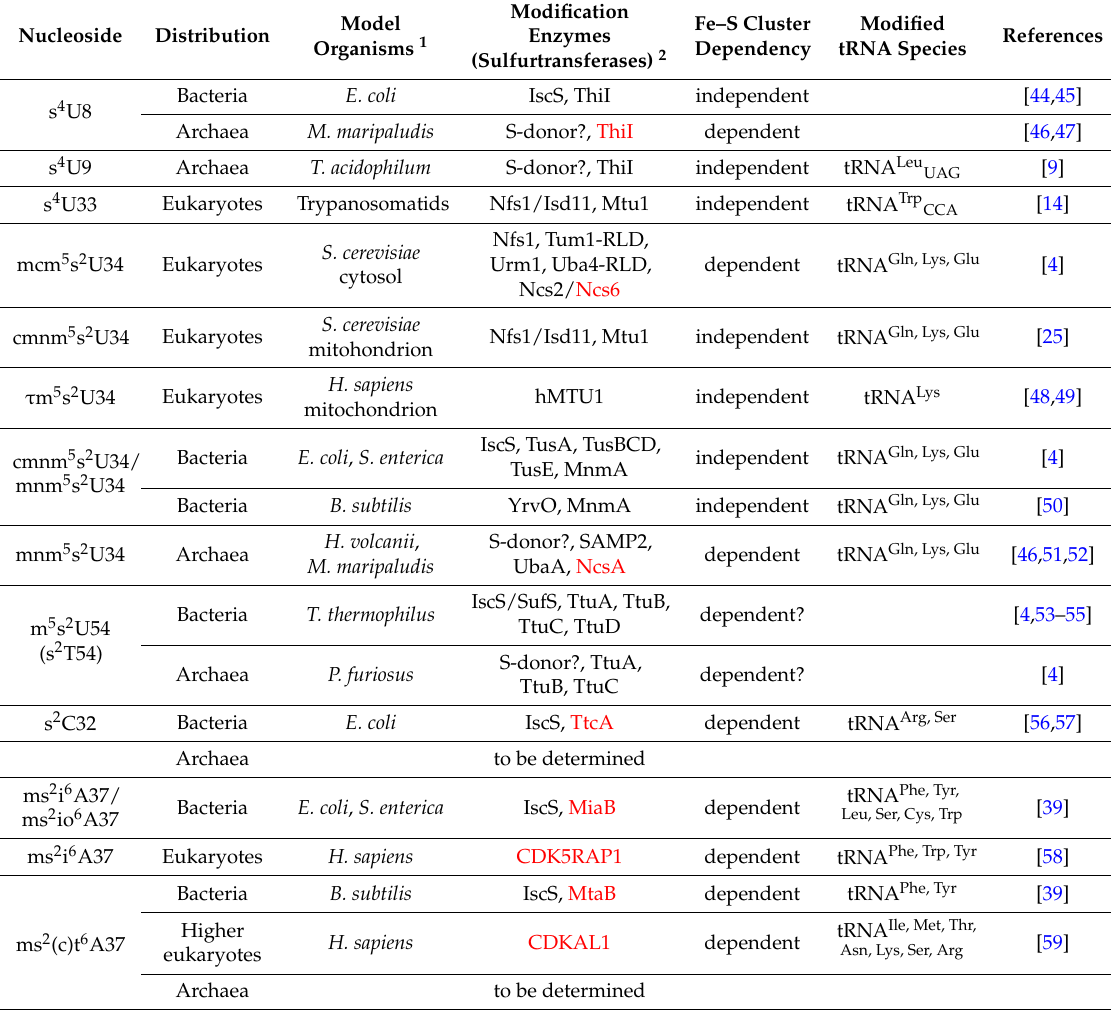
Table 2. The diversity and distribution of tRNA thionucleosides and sulfurtransferases involved in each